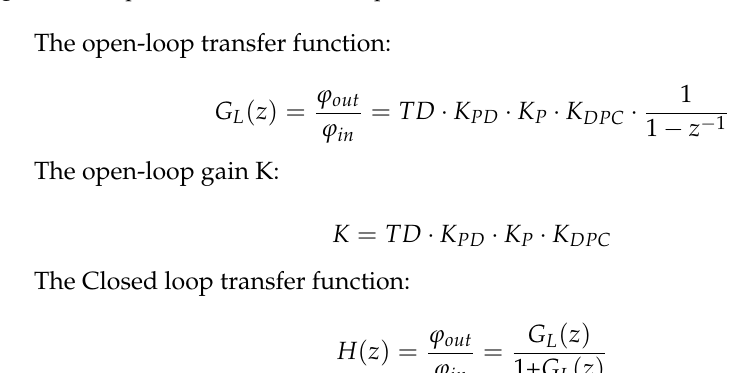
Figure 15. Simplified model of CDR loop.